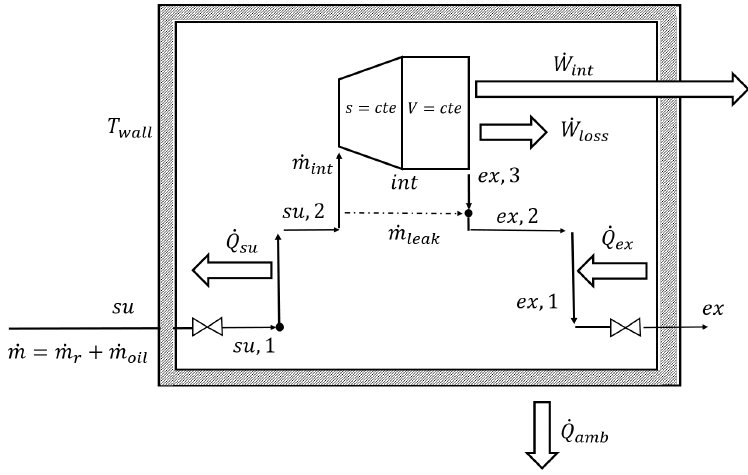
Figure 5. Schematic of the semi-empirical model of a oil-flooded volumetric